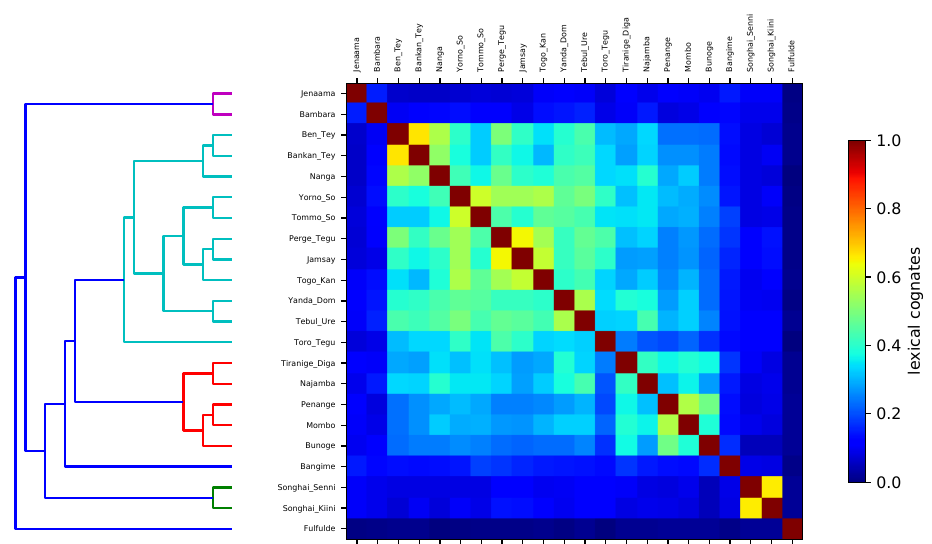
Figure 4: Heat Map generated from the cognate percentages inferred by the SCA ap‑ proach. The “cognates” selected by the SCA approach which appear here as lighter col‑ ors on the spectrum towards red in the middle, where each language is compared with itself, can be interpreted as borrowings rather than leading us towards genetic